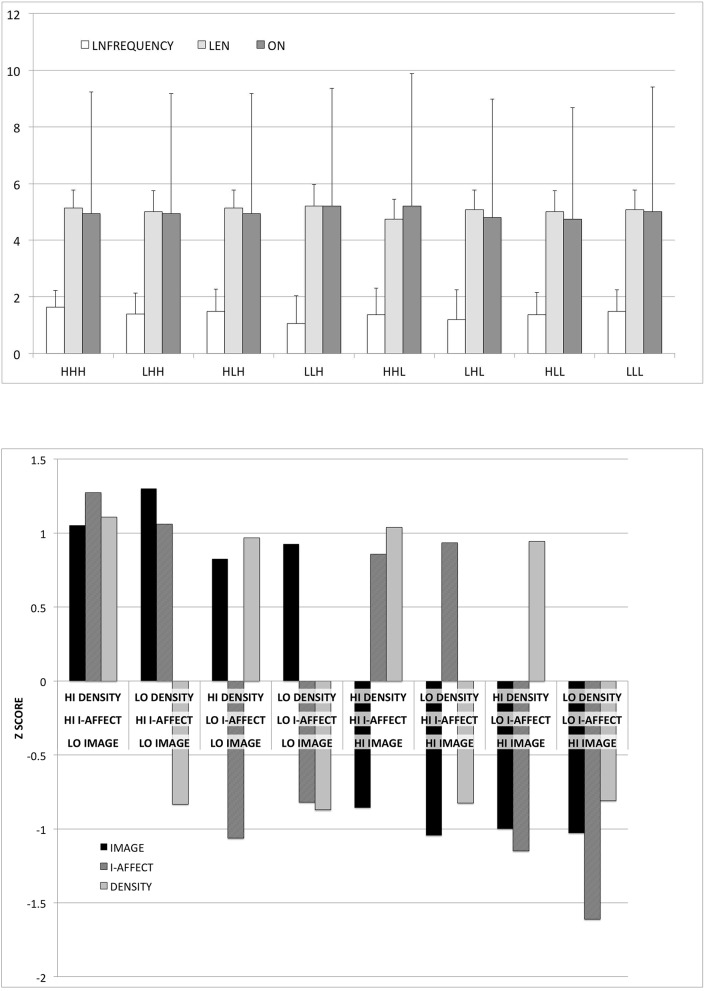
Graphical illustration of stimuli properties. Above: Logged orthographic frequency [LNFREQUENCY], length [LEN], and orthographic neighborhood size [ON], in each of the eight categories formed by crossing high/low imageability by affect by context. Bars show standard deviation. Below: Standardized imageability judgments , affect estimates [I-AFFECT], and co-occurrence density [DENSITY] estimates in each of the eight categories. Bars show standard deviation.